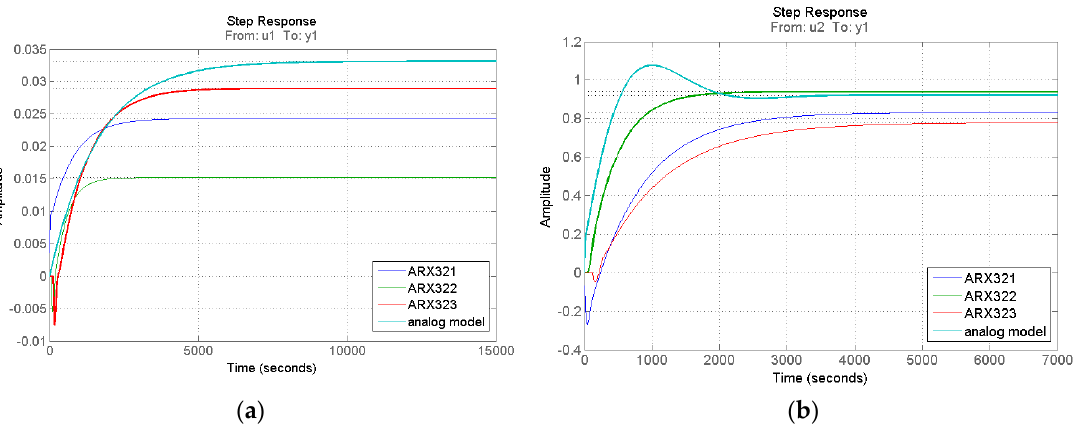
Figure 2. Step responses for digital and analog model: ( a ) segment G1 and ( b ) segment G2.